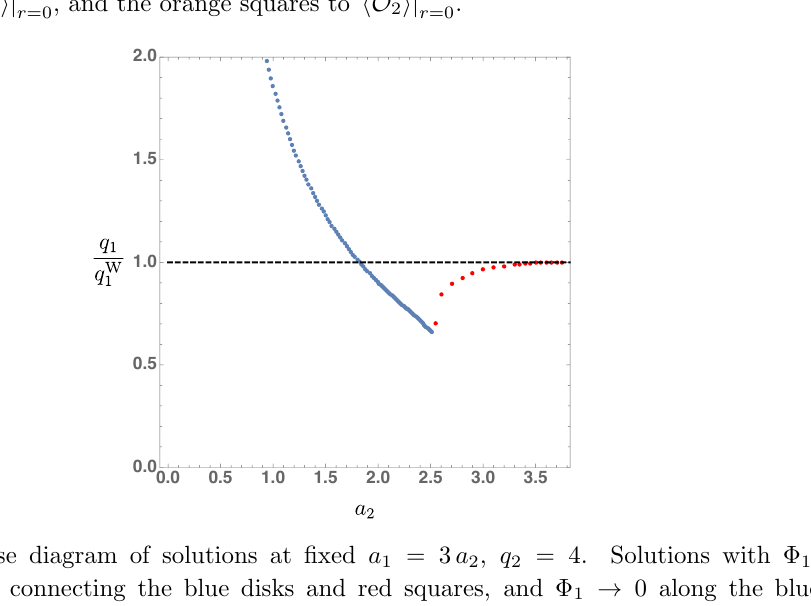
Figure 10 . hO I ij correspond to hO 1 ij